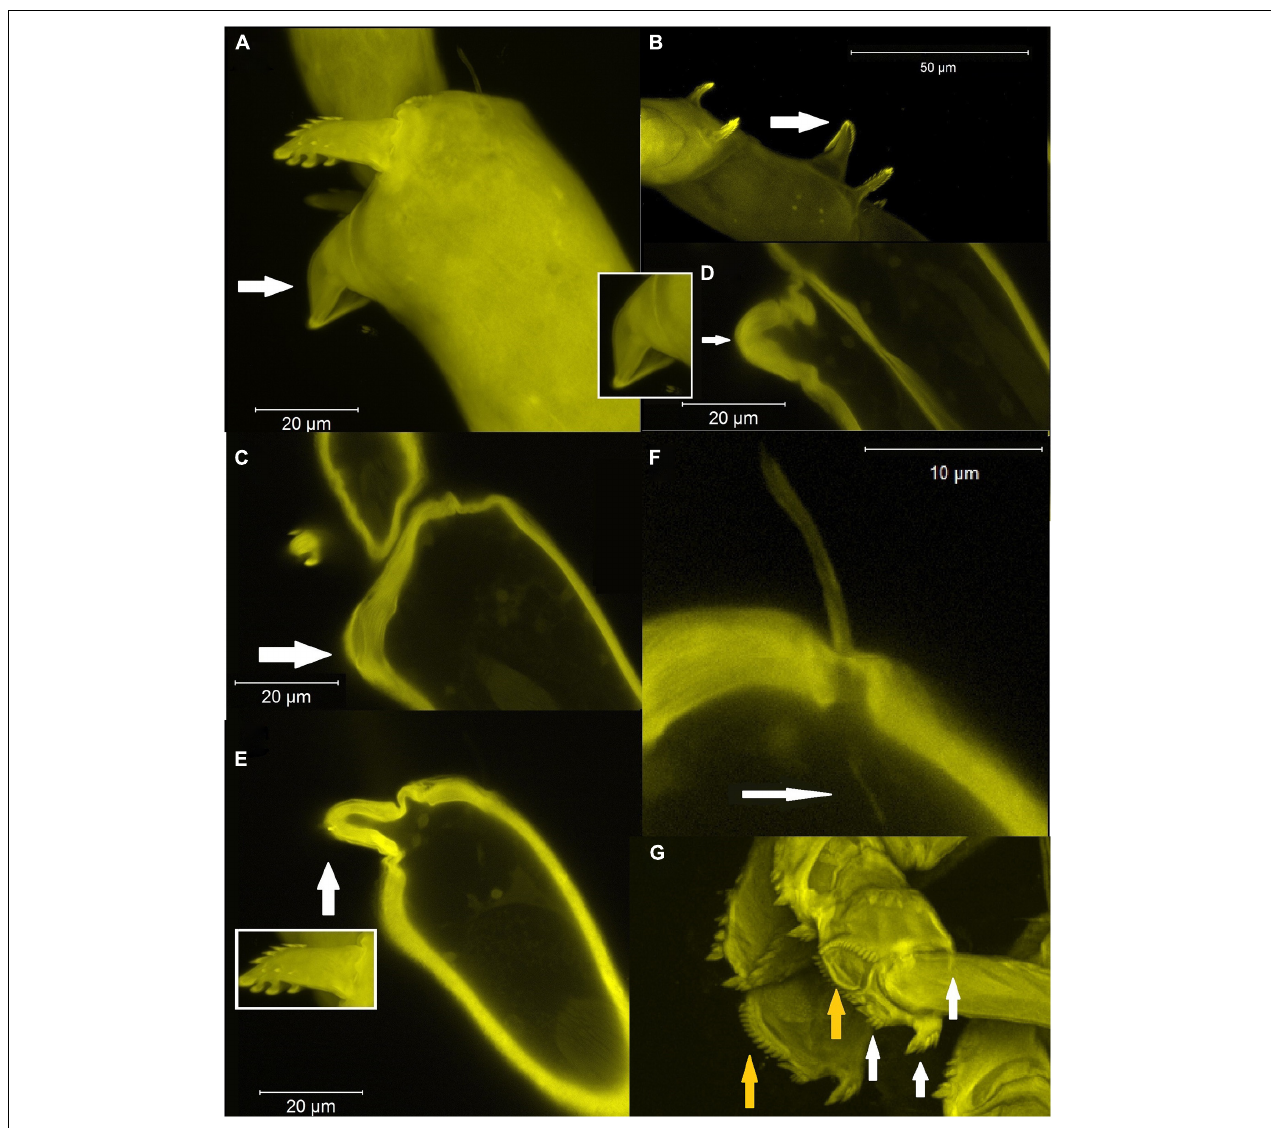
FIGURE 8 | CLSM images of pereopods. Maximum intensity projections [panels (A,B,G) and insets] or single optical cross sections (C–F) are shown. (A–E) Structure and morphology of pereopods 4–6 hooks and setae. (A) Ornamentation of the pereopod-4 carpus in H. mojito n. sp. (arrow indicates a smooth molariform spine); (B) ornamentation of the pereopod-4 carpus in H. caipiroska (arrow indicates a serrated molariform spine); (C–E) Optical cross section through a smooth (C,D) and serrate (E) hooks; (F) optical cross section through seta (arrow indicates innervation); (G) prickly tubercles in Torquella sp.—white arrows indicate hooks (dorsodistal seta obscured), orange arrows the separate prickly tubercles.